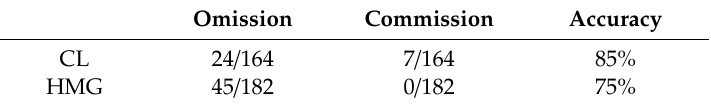
Table 3. Omission and commission error of the automatic tree crown